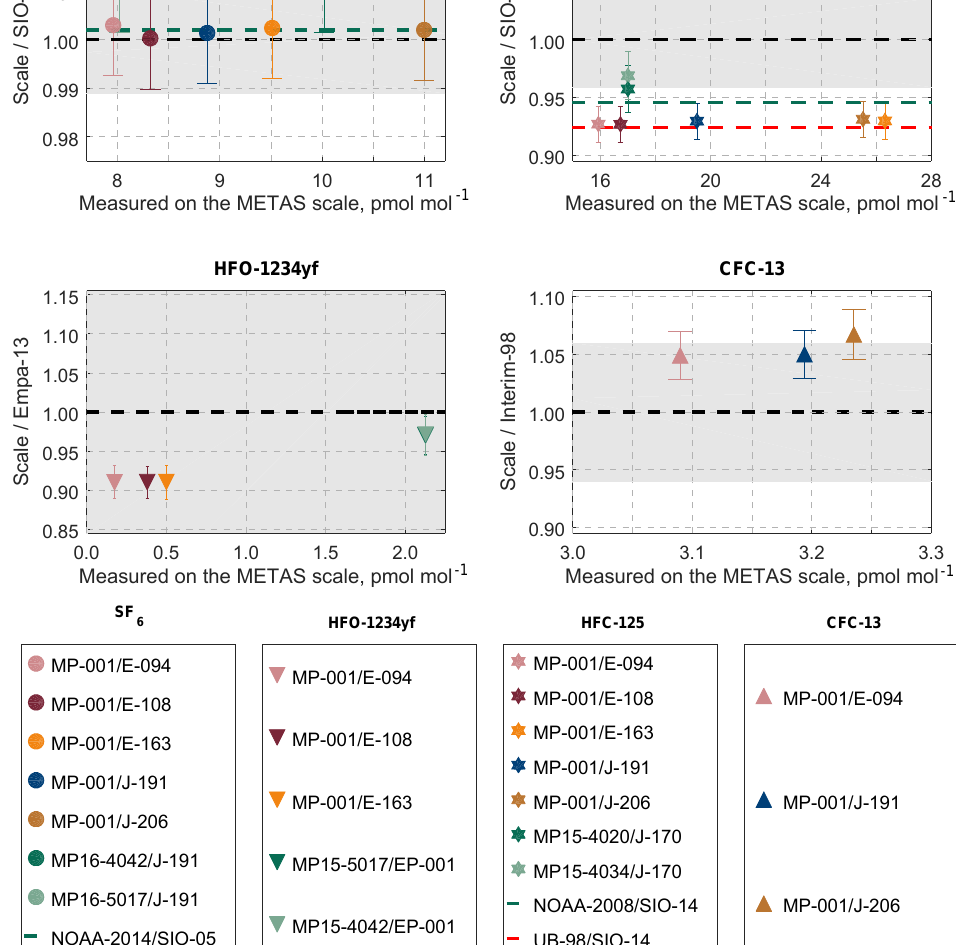
Figure 6. Comparison to existing calibration scales. Results are shown as ratios of values on the METAS scale divided by values on the historical scale. Results where both scales are in perfect agreement would line on the 1 : 1 line (dashed, black line). The grey area repre- sents the uncertainty associated with the historical scale plus the scale transfer uncertainty (see description in Sect. 4.1). Markers represent measurement results of cylinder comparisons. Error bars on the markers take into account uncertainty of the METAS scales as well as the measurement reproducibility. Results on METAS and historical scales are in agreement within uncertainties as soon as the error bars touch the grey area. Additional dashed lines represent published conversion factors between SIO scales and other scales, i.e. NOAA (green) and University of Bristol (UB-98, red). An overview of results from this work and used conversion factors can also be found in Table